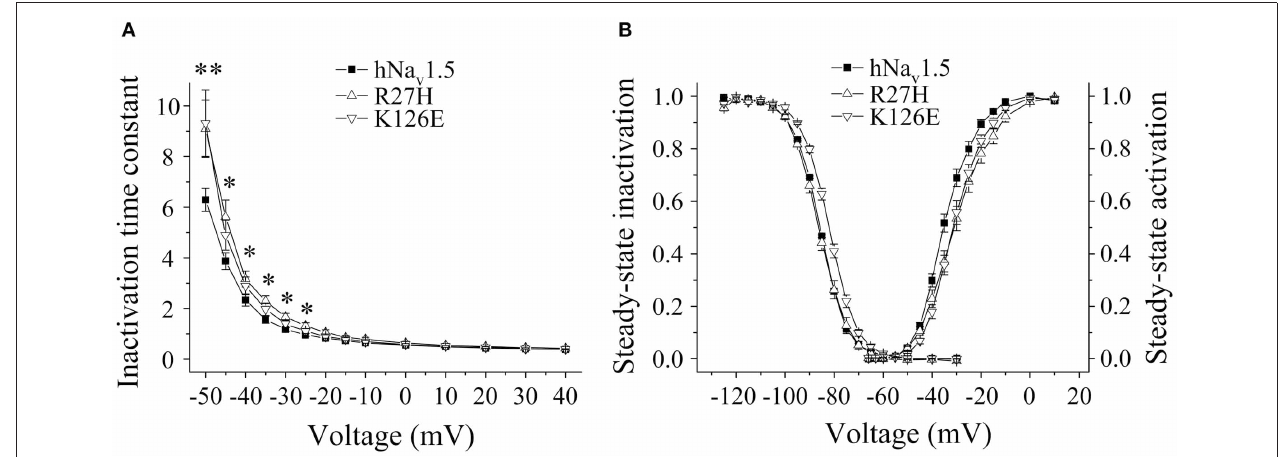
inactivation curves. Mid-activation potentials ( V m ) were significantly shifted towards depolarized potentials in both R27H and K126E. Mid-inactivation potential V h was shifted only in K126E. The figure was drawn using the mean of 4 representative measurements for each. V m and V h of the other mutant channels, R18Q, G35S and V95I, were indistinguishable from the respective hNa v 1.5 values. For data and statistics see Table 2